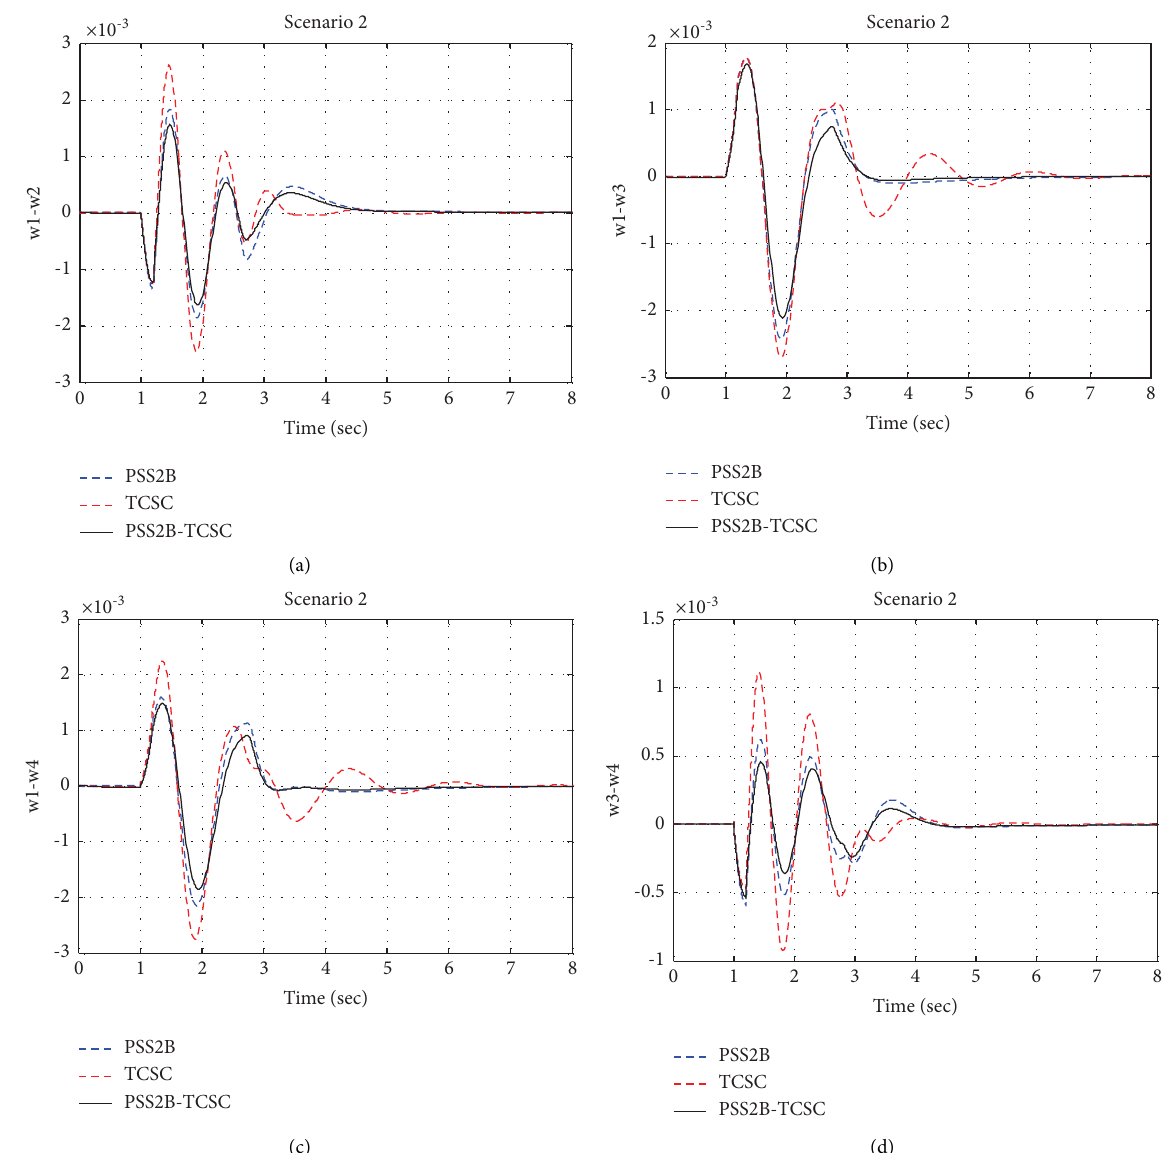
Figure 16: Te interarea and local modes oscillations in the second scenario.